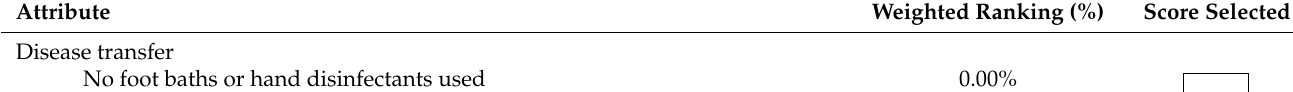
Table 4. A value model (%) for rating the welfare of lion cubs used in tourism (wildlife interaction facilities).